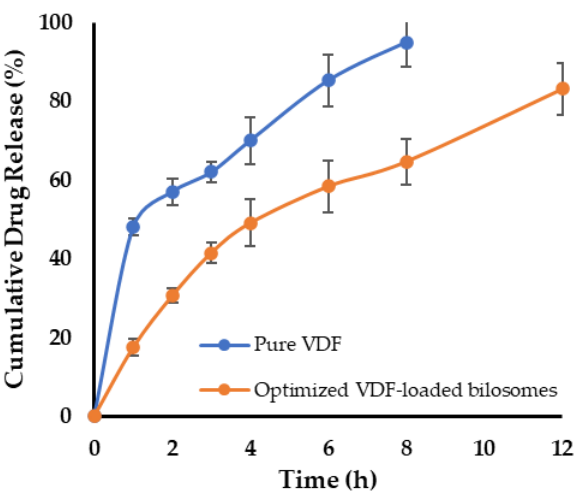
Figure 6. In vitro release profile of VDF -loaded bilosomes . Data represent mean ± SD of three inde- pendent